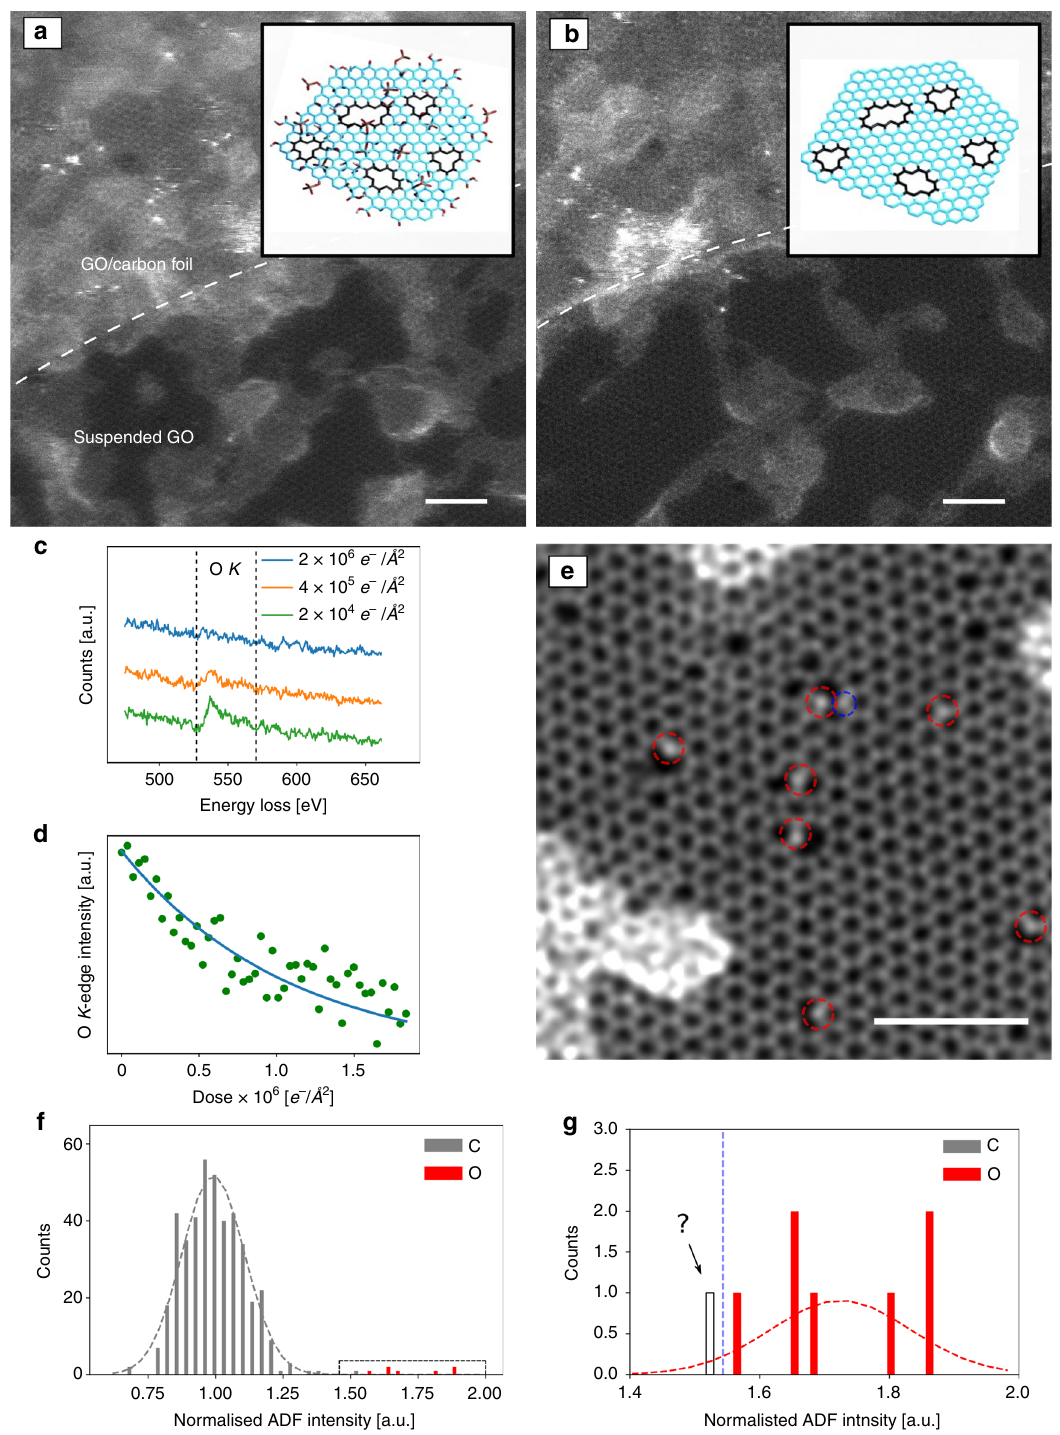
Fig. 1 Reduction of GO under the beam. Lower magni fi cation (lattice resolution) STEM images: a initial and b after ~50 scans. Adsorbates shrink under observation, and the clean lattice area increases. The insets show a model with and without functional groups attached to the graphene sheet (reduced GO). The upper left section of the image contains the supporting carbon fi lm. c EEL spectra after different electron doses showing the loss of the oxygen K -edge. d EEL intensity of the oxygen K -edge as a function of electron dose. e High magni fi cation double-Gaussian fi ltered image where the graphene lattice with defects and impurities is resolved. The bright atoms (red dashed circles) can be identi fi ed as oxygen. The atom in the blue dashed circle is at the edge of the intensity distribution and might be either nitrogen or oxygen. f Histogram of the ADF intensities of carbon (gray) and oxygen atoms (red). g Magni fi ed histogram of panel f . Insets in a , b are reprinted from ref. 10 with permission. Scale bars are 2